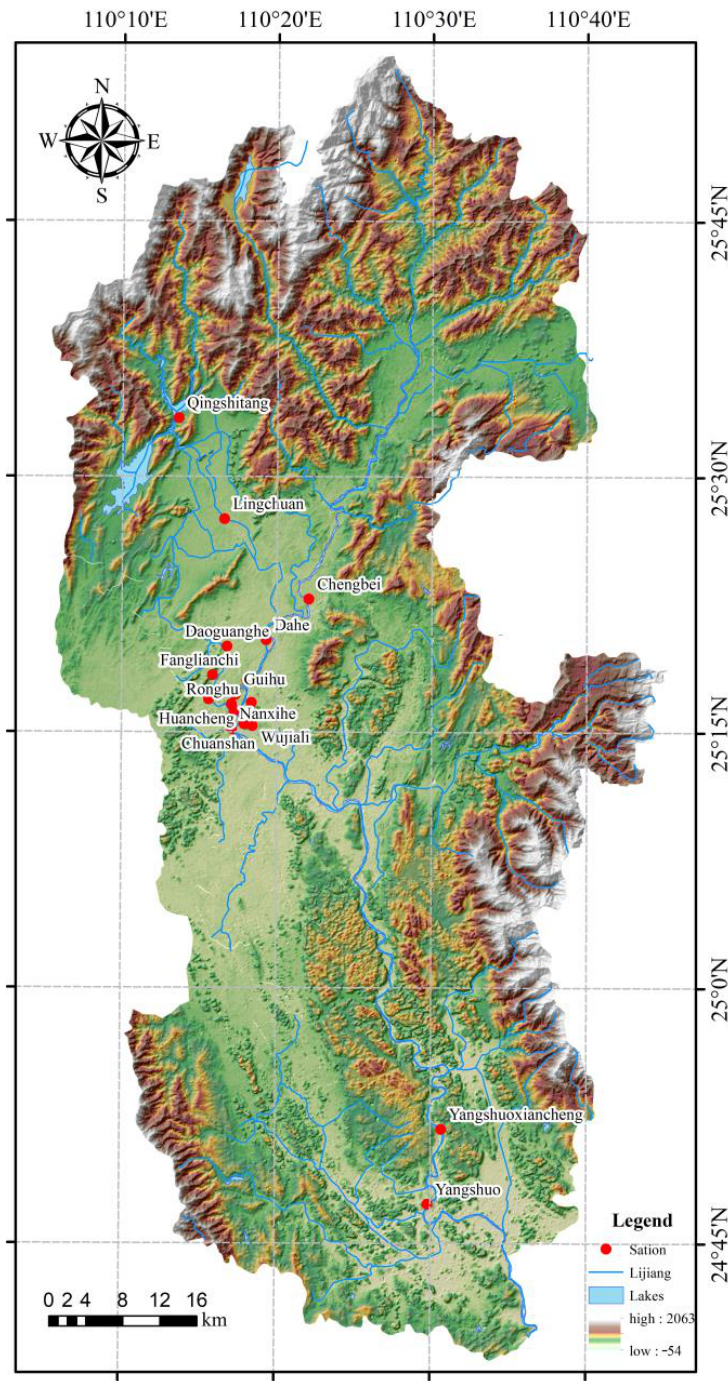
Figure 1. Distribution of stations in the Lijiang River Basin.